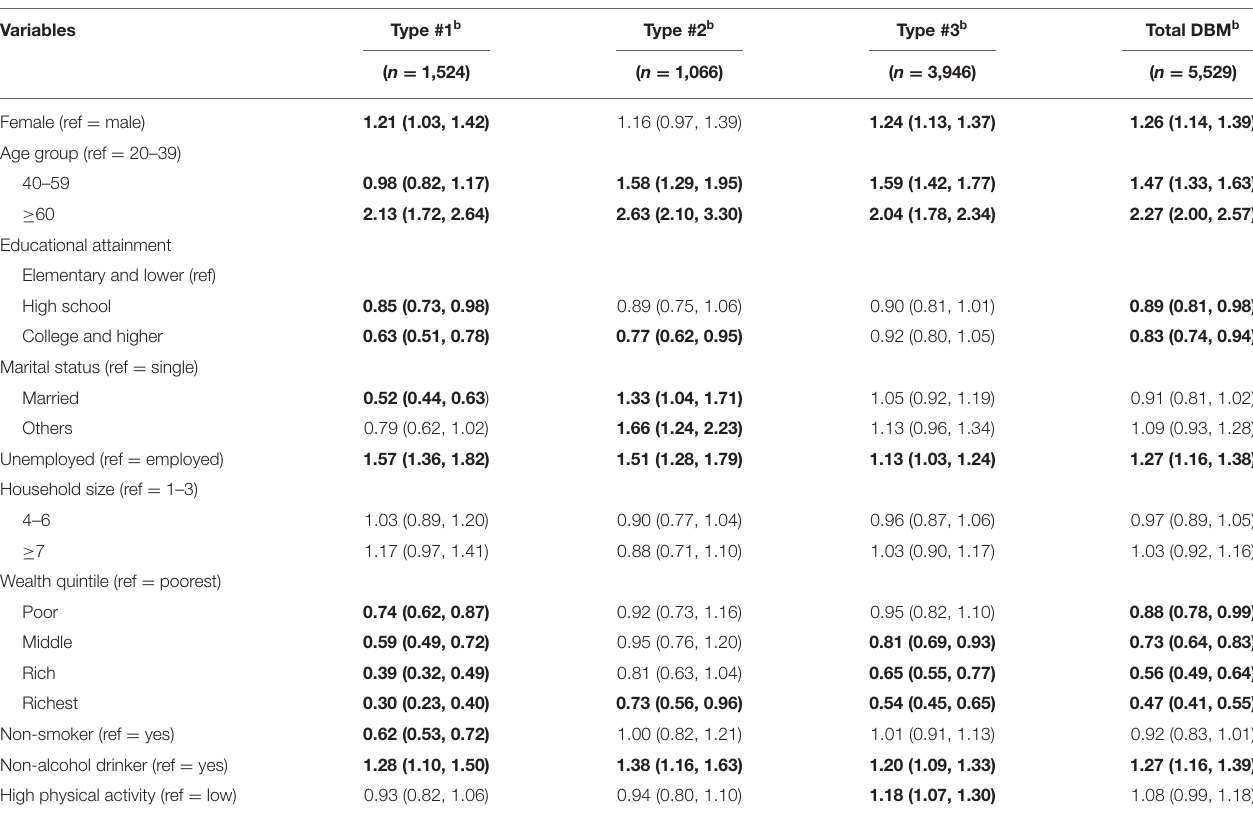
TABLE 4 | Factors associated with the double burden of malnutrition characterizations a .